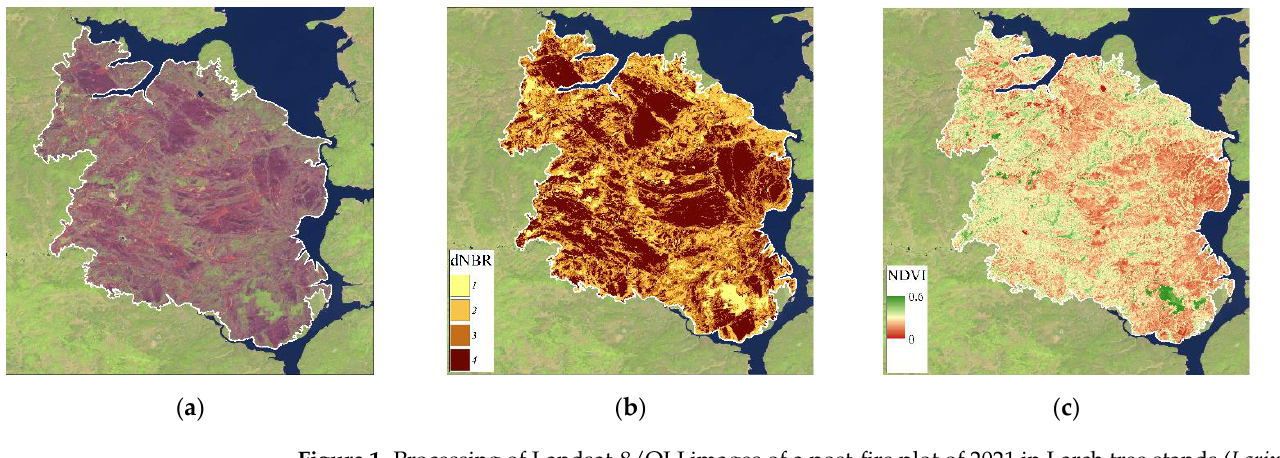
Figure 1. Processing of Landsat-8/OLI images of a post-fire plot of 2021 in Larch tree stands ( Larix sibirica ): ( a ) post-fire plot; ( b ) dNBR index values; ( c ) distribution of NDVI.